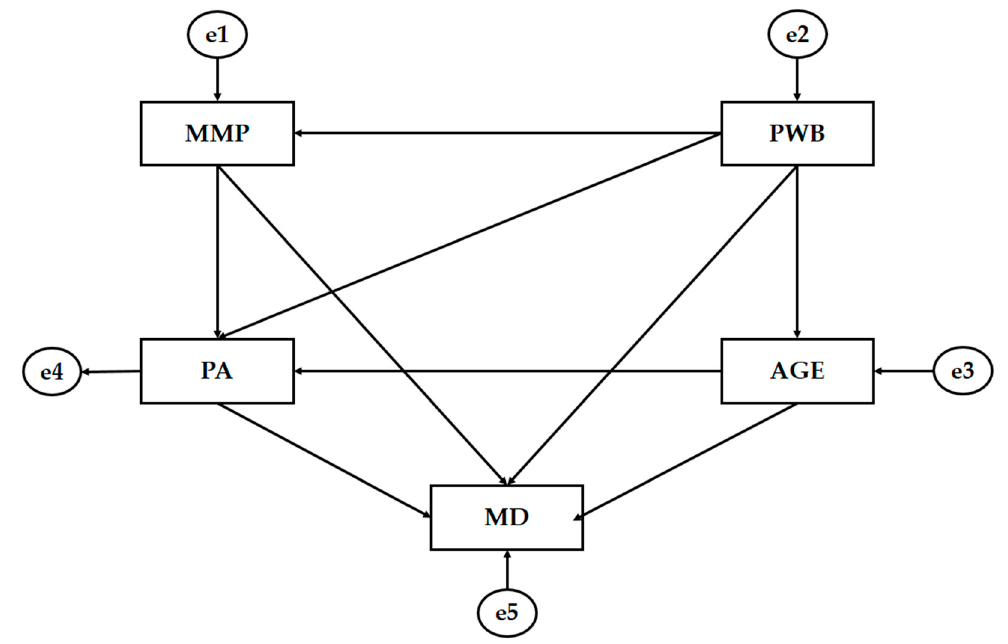
Figure 2. The theoretical model. Note: Mass media pressure (MMP); Mediterranean diet (MD); physical activity (PA); psychological well-being (PWB); age (AGE); error (e).